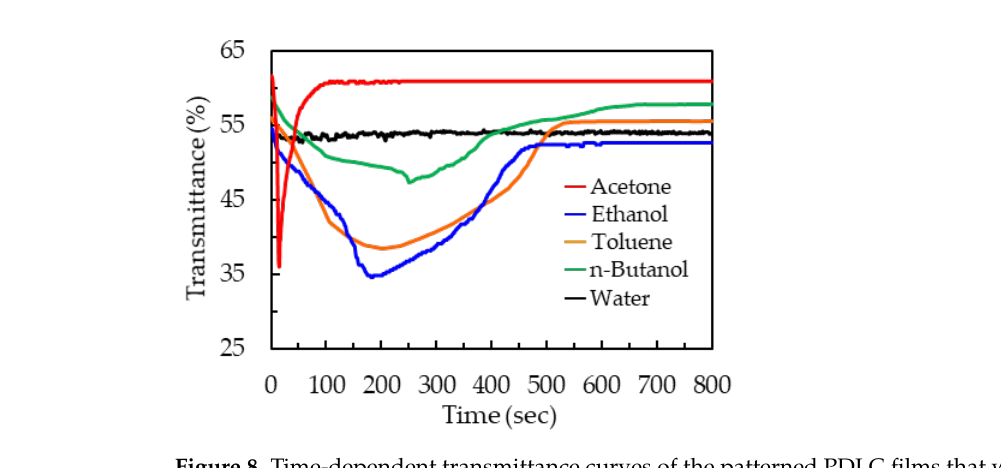
Figure 8. Time-dependent transmittance curves of the patterned PDLC films that were exposed to acetone, ethanol, toluene, n-butanol, and water.